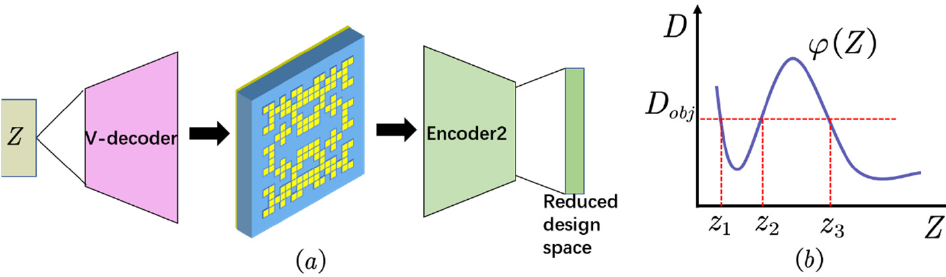
Figure 7. ( a ) A network for the VAE generated continuous latent vector into RDV. ( b ) The functional relationship between latent continuous vectors and RD.